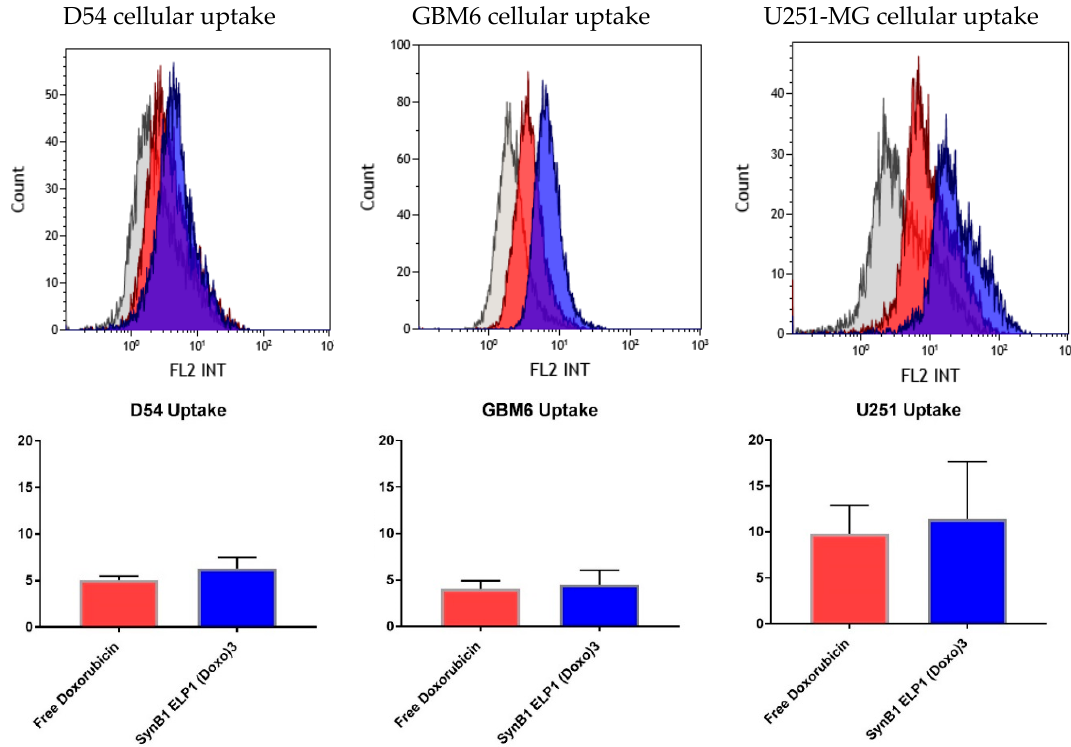
Figure 3. The upper panel shows representative cellular uptake histograms for D54, GBM6, and U251-MG cell lines. The lower panel represents average geometric mean of uptake for three independent experiments. Y-axis represents a relative fluorescence unit. Error bars are